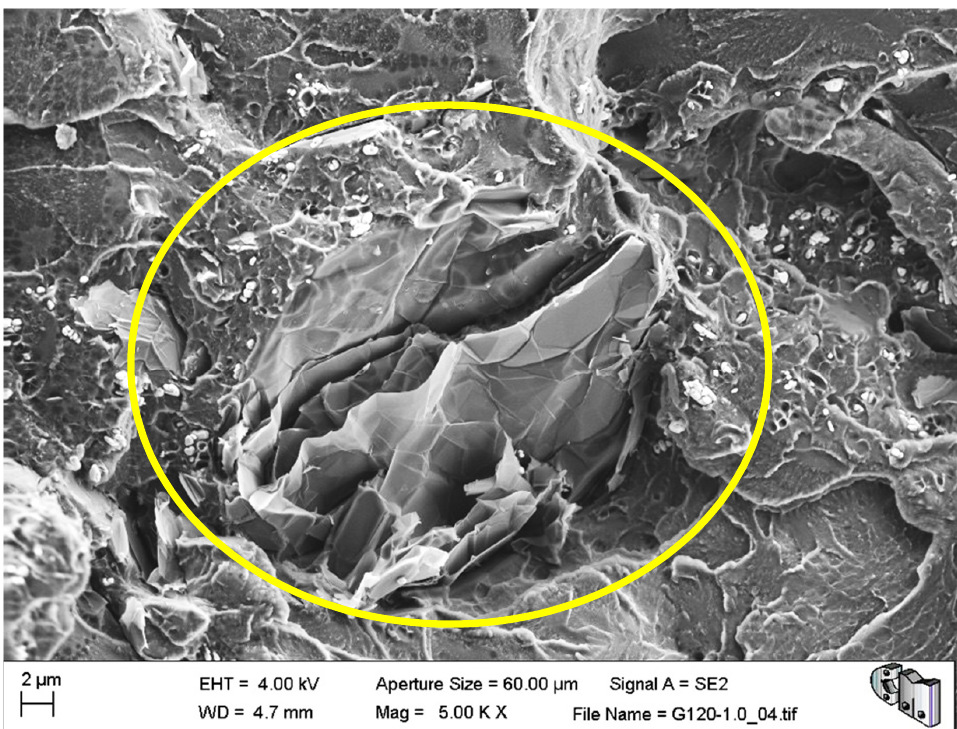
Figure 7. G120-1.0 fracture surface with a HRGO agglomerate perpendicular to the fracture surface.